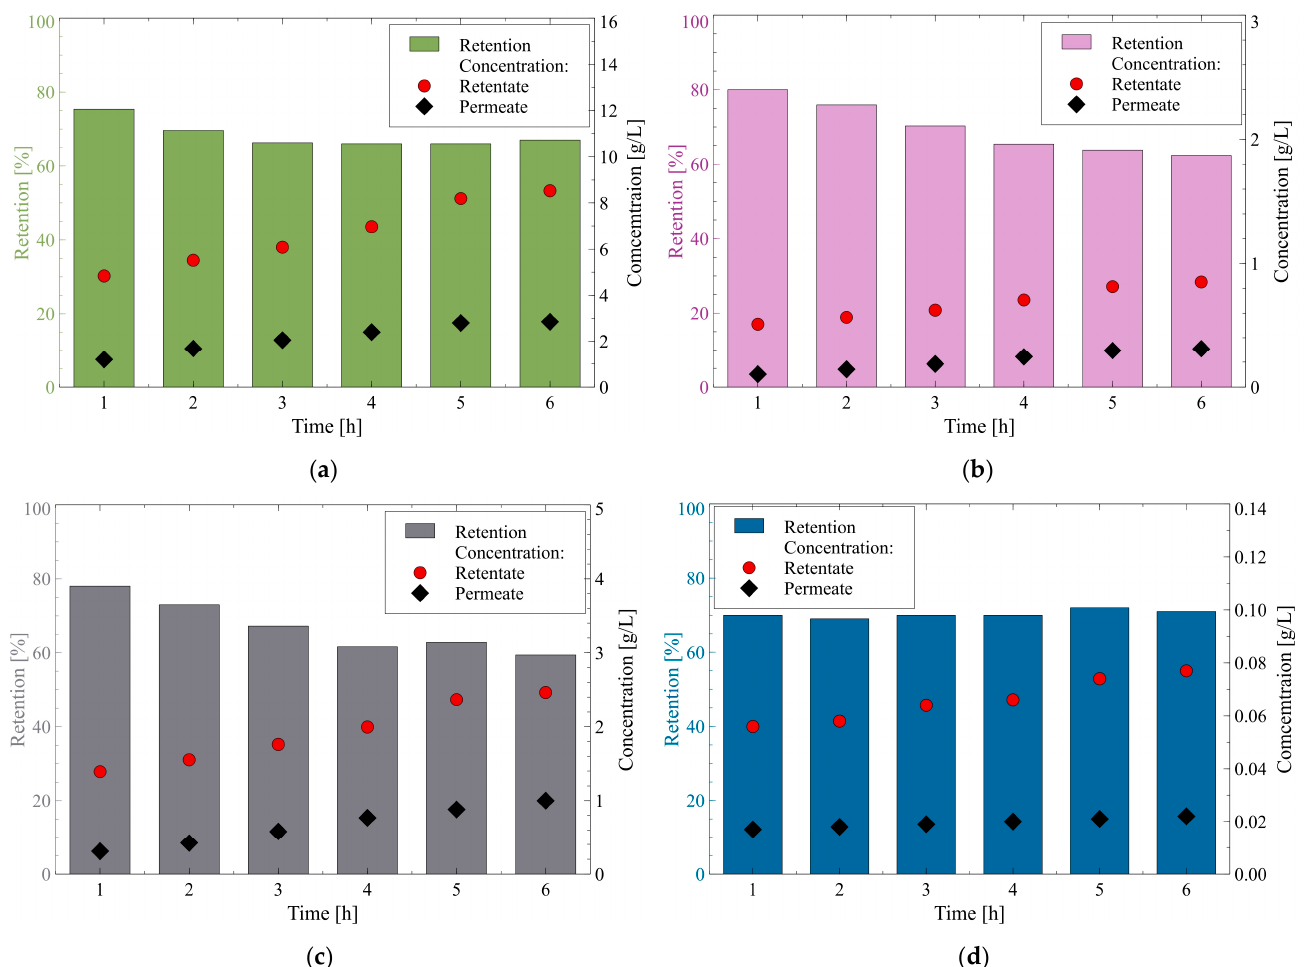
Figure 12. Changes in the retention and concentration of cations during the NF process of fermentation broth: ( a ) Na + ; ( b ) NH 4+ ; ( c ) K + ; ( d ) Ca 2+ . TMP = 1.4 MPa, T = 298 K.